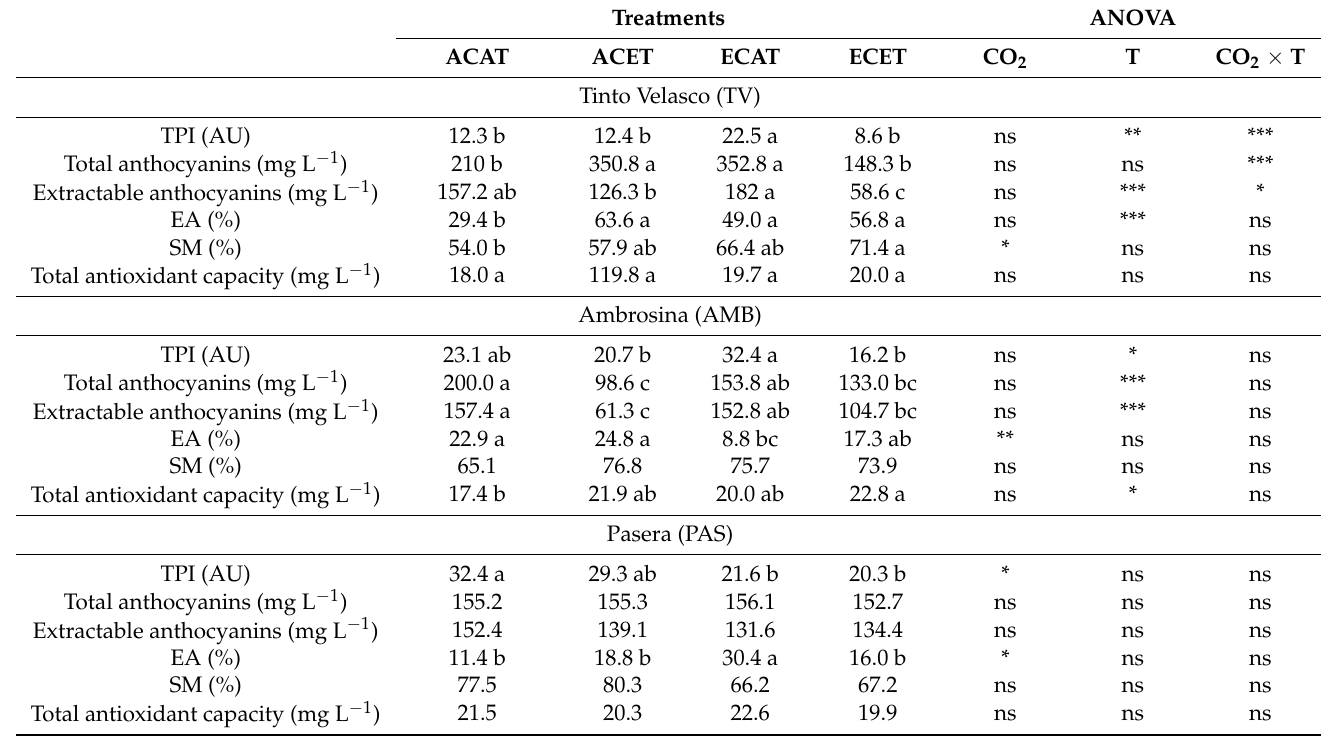
Table 2. Phenolic composition and antioxidant capacity of must from three Spanish autochthonous grapevine varieties cultivated at (1) ambient (~400 µ mol mol − 1 ) CO 2 concentration (AC) and ambient temperature (AT) (ACAT); (2) AC and elevated (T + 4 ◦ C, ET) temperature (ACET); (3) elevated CO 2 (700 µ mol mol − 1 , EC) and AT (ECAT), and (4) EC and ET (ECET). Values are means (n = 3–6). Within each parameter and grapevine variety values followed by same letter or